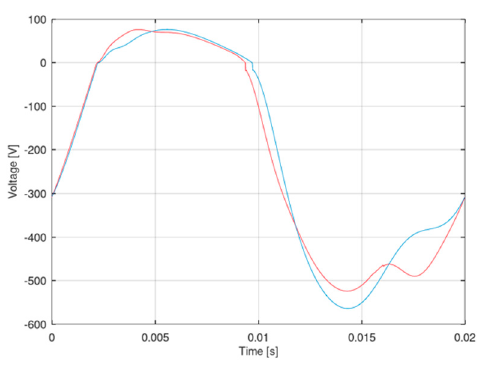
Figure 16. Comparison of the voltage across the nonlinear load in the time domain (illustrative example 1—in blue vs. Illustrative example 2—in red).